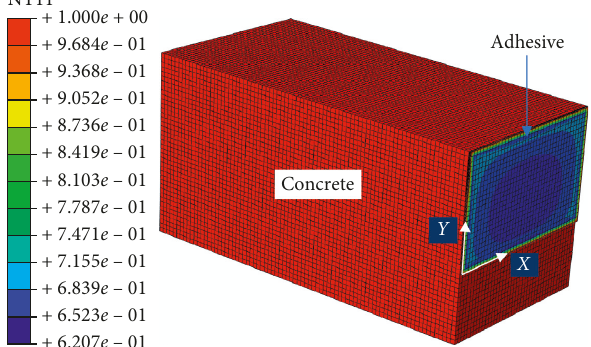
Figure 10: Typical FEM results of moisture content distribution.